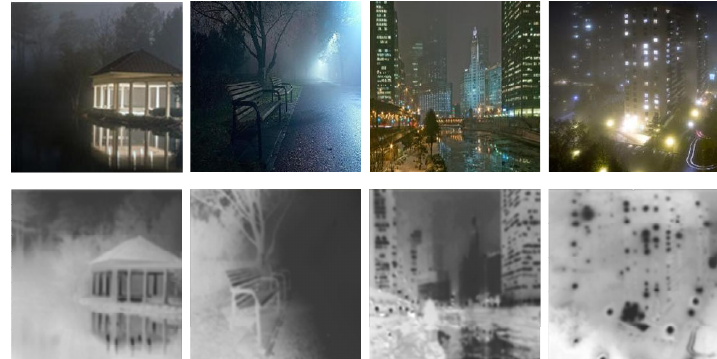
Figure 5. Haze images and their corresponding transmission maps. The hazy images of the first row are fed into the transmission computing network to obtain the transmission as shown in the second